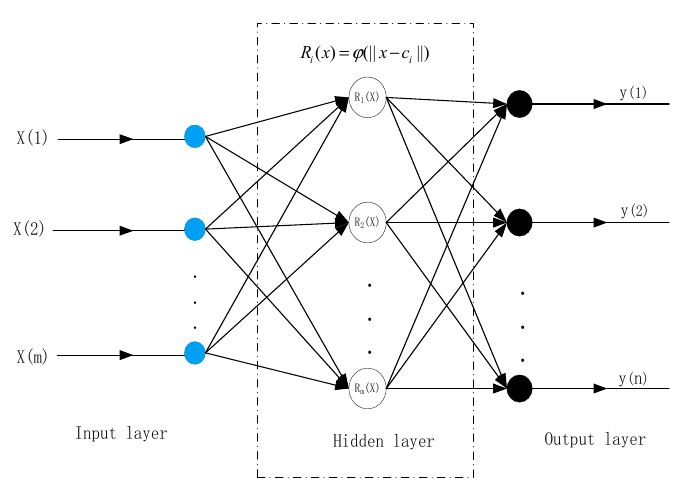
Figure 15. RBF neural network model structure.